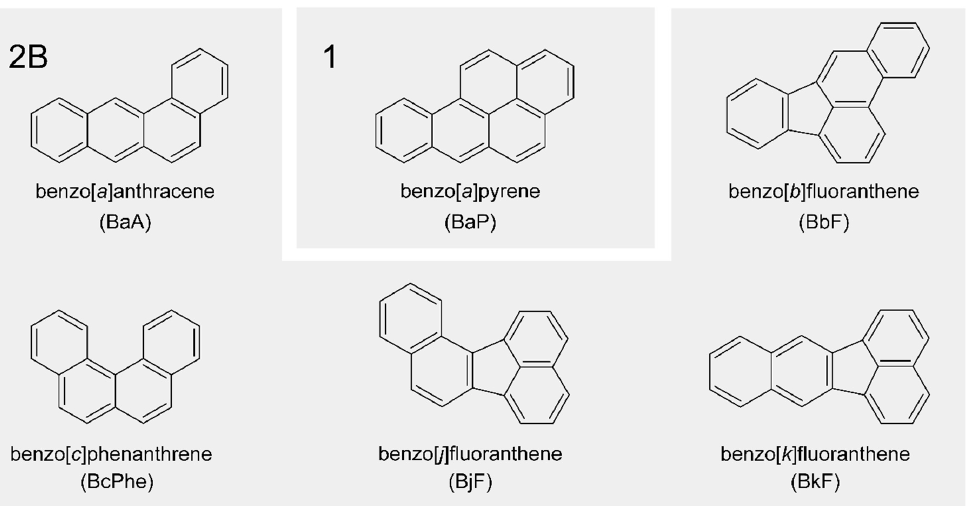
Figure 1. Chemical structures of polycyclic aromatic hydrocarbons (PAHs) used in this study in alphabetical order. PAHs are clustered additionally according to their International Agency for Research on Cancer (IARC) classification. Group ( 1 ): carcinogenic to humans; group ( 2A ): probably carcinogenic to humans; group ( 2B ): possibly carcinogenic to humans; group ( 3 ): not classifiable as to its carcinogenicity to humans [22]. 2. Results 2.1. Cytotoxicity Cytotoxicity was analyzed beforehand for all PAH concentrations using the 3-(4,5- dimethylthiazol-2-yl)-2,5-diphenyltetrazolium bromide (MTT) cell viability assay. Cell vi- ability was determined 24 h or 48 h after treatment for HepG2 or HepaRG cells, respec- tively. None of the concentrations used in this study decreased cell viability of HepaRG or HepG2 cells below 80% (see Figure 2).